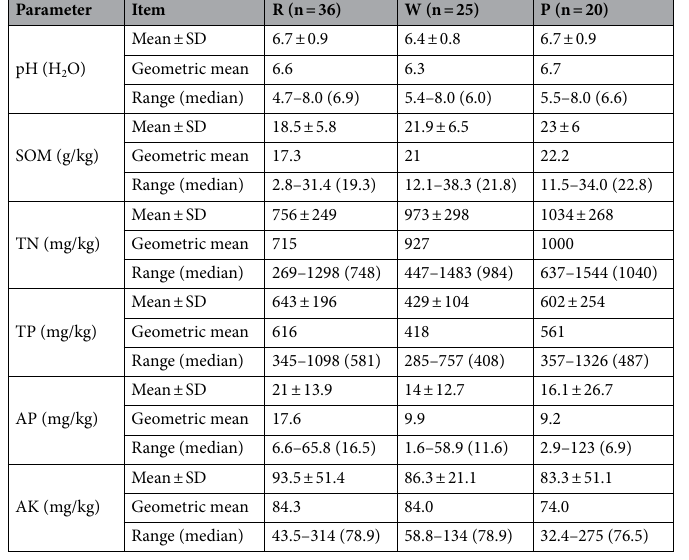
Table 1. Summary of main chemical properties of soils collected in the study area. R rape field soil, W wheat field soil, P paddy field soil, SOM soil organic matter, TN total nitrogen, TP total phosphorus, AP available phosphorus, AK available